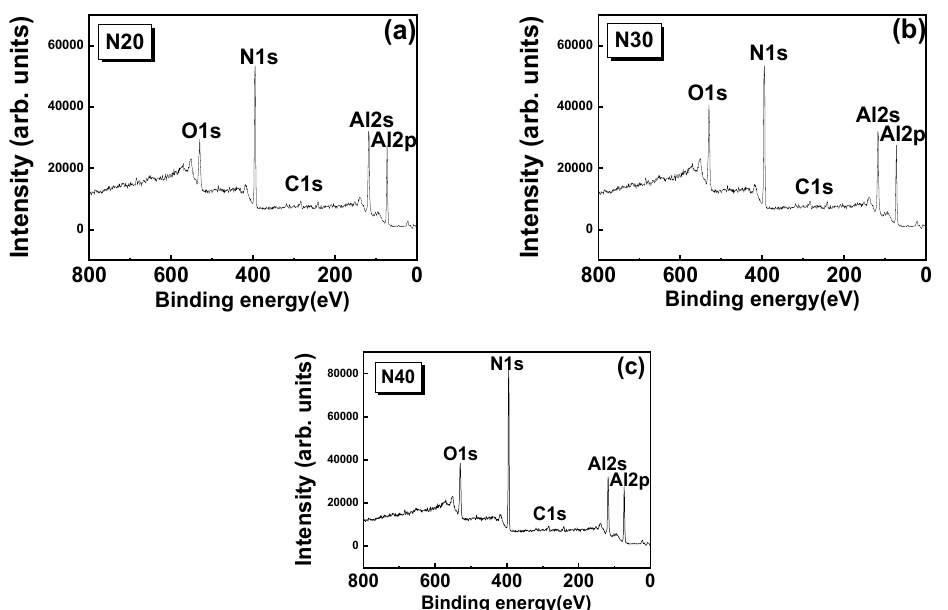
Figure 3. XPS survey spectrum of AlN thin films sputtering deposited using N 2 flow rate of ( a ) 20, ( b ) 30, and ( c ) 40 sccm.